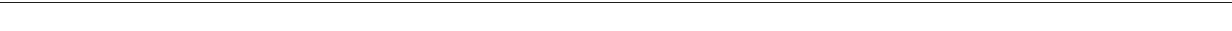
Fig. 4 ZNF506 is required for the maintenance of genomic stability. a Loss of ZNF506 leads to genomic aberrations as indicated by micronuclei formation. ZNF506 was knocked out in normal human fi broblasts using CRISPR. Cells were stained with DAPI to assess micronuclei formation. Inset, representative image of cell with micronucleus. b ZNF506 is required for class switch recombination. Shown is a representative image of IgM to IgA conversion with treatment (left panel). c Loss of ZNF506 or lack of ZNF506 phosphorylation sensitizes cells to radiation. d Mutations in T-PLL identi fi ed in our patient sample. e The mutations in ZNF506 that were identi fi ed in patient samples lead to aberrant DNA damage response. f The patient mimetic mutations of ZNF506 disrupts the interaction between EYA1 and ZNF506 but not MDC1 and ZNF506. g The patient mimetic mutations of ZNF506 sensitizes cells to irradiation (IR). h Model for the role of ZNF506 in response to DNA double-strand break. We propose that ATM-mediated phosphorylation of ZNF506 promotes its interaction with MDC1 and recruits it to the DNA double-strand break site. It subsequently recruits the phosphatase EYA to the damage site. EYA, in turn, dephosphorylates H2AX at Y142 to recruit downstream repair factors and gradually amplify the DNA damage response for proper DNA double-strand break signaling. Shown are the representative data (mean ± SEM) from three independent experiments in a – c , e , and g . ** p < 0.01 by ANOVA for control vs. each shRNA in b . ** p < 0.01 by ANOVA for vector and ZNF506 sgRNA + FLAG ZNF506 WT vs. all other groups at each dose of IR in c . ** p < 0.01 by ANOVA for ZNF506 sgRNA + FLAG ZNF506 WT vs. all other groups with IR in e . ** p < 0.01 by ANOVA for vector and ZNF506 sgRNA + FLAG ZNF506 WT vs. all other groups at each dose of IR in g . Representative western blots in f are provided from three biologically independent experiments. Unprocessed blots are provided in Supplementary Fig.